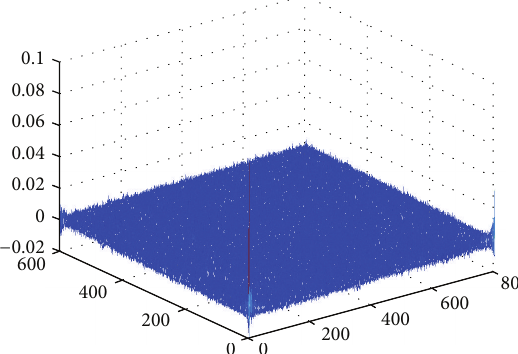
Figure 6: POC function for COEP palmprint database.